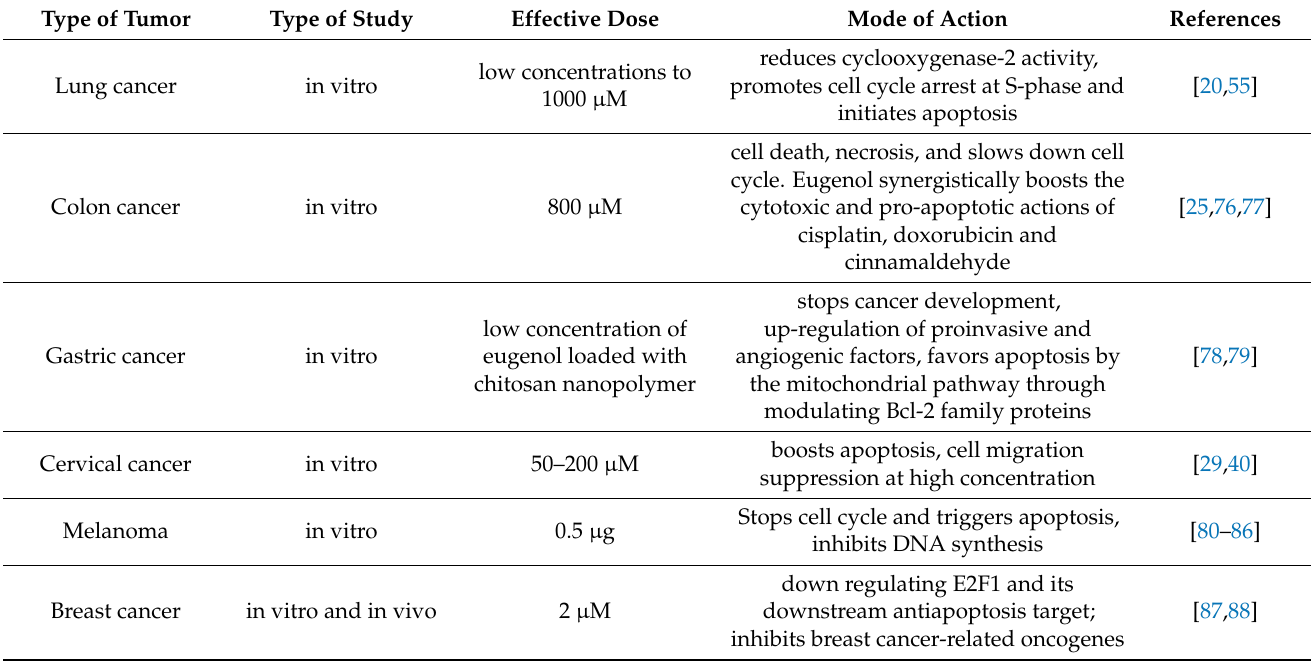
Table 1. Anticancerous potential of eugenol against several cancer